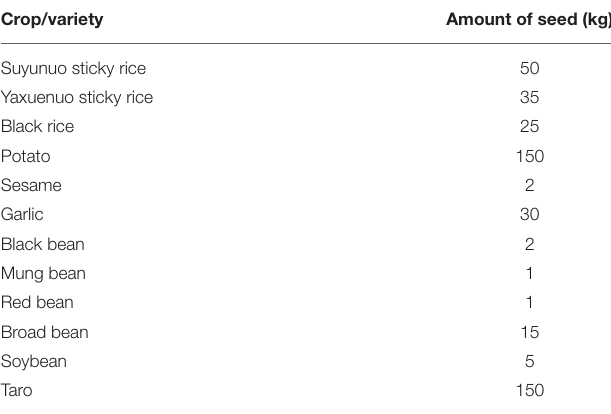
TABLE 6 | Crops/varieties conserved in the Kunshan seed bank (2020).